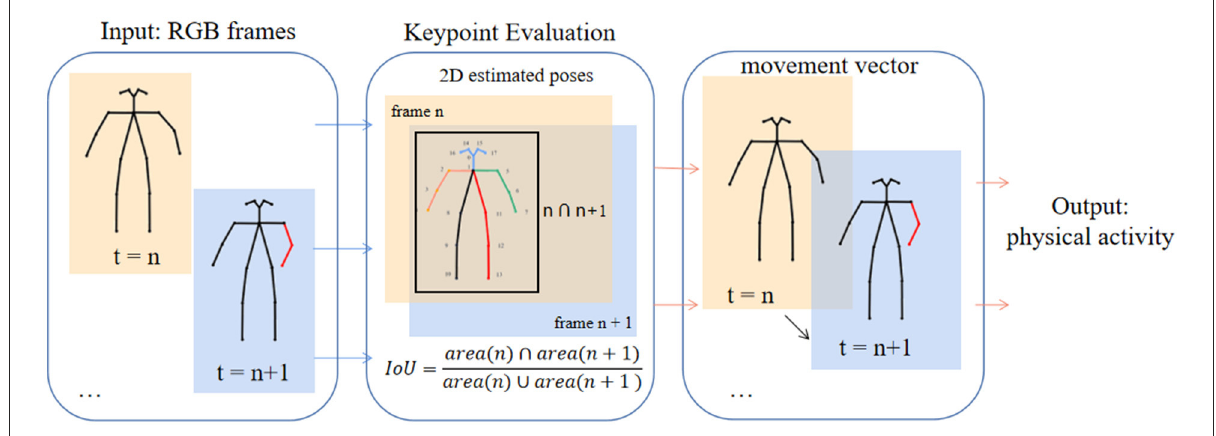
FIGURE3 The process of calculating the physical activity of the participant in every two frames of the image. The publication of the information in this figure was agreed to and authorized by the participant.